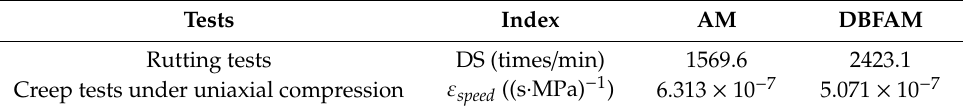
Table 11. Test results of high-temperature permanent deformation